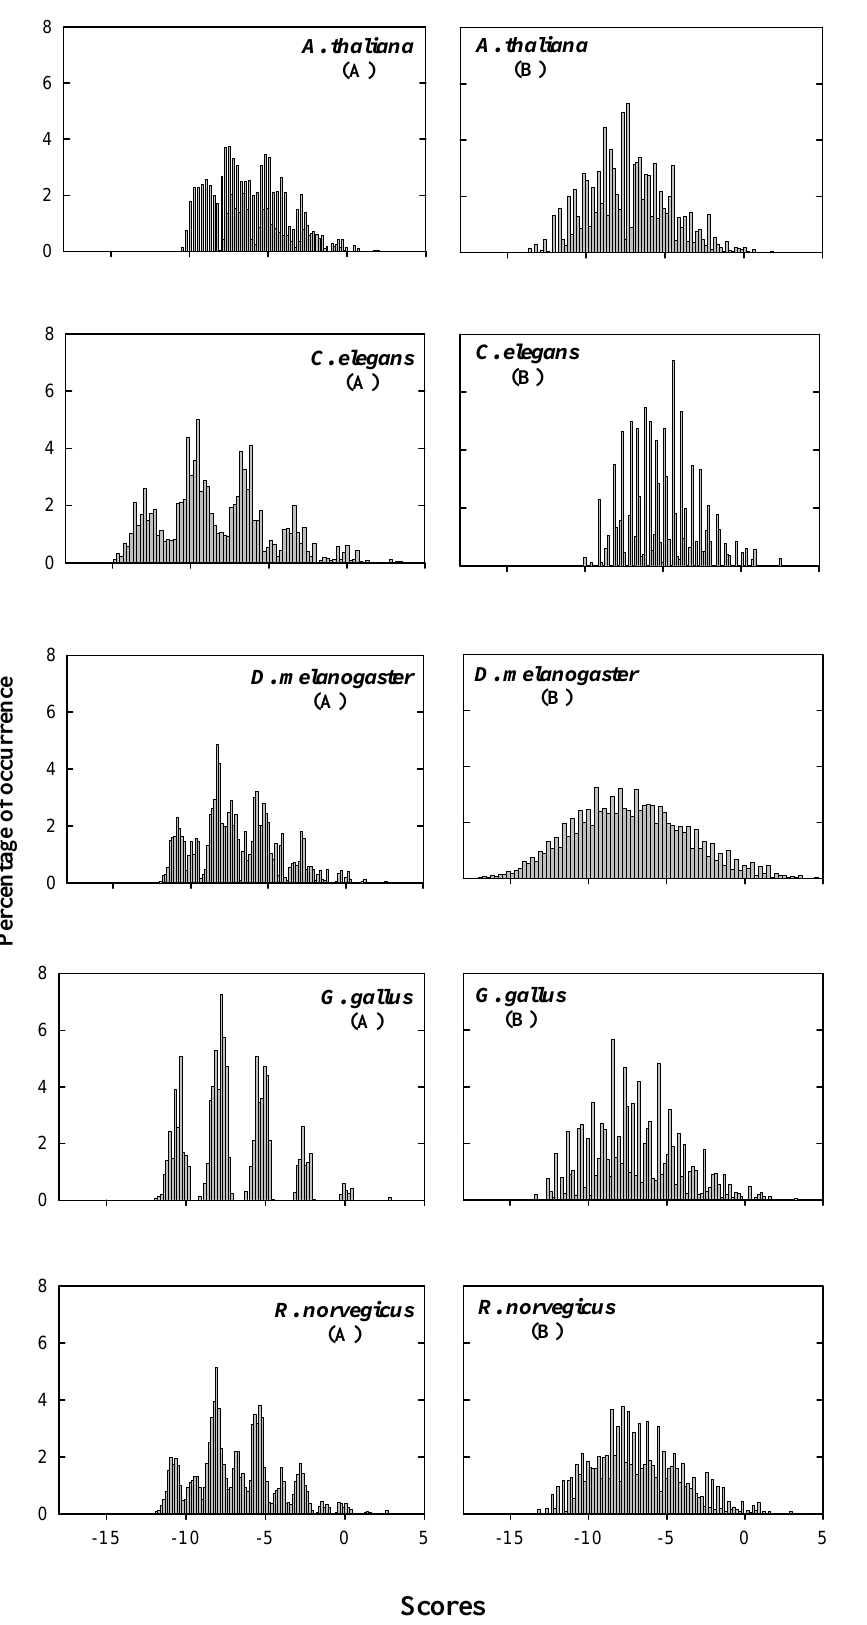
Fig 3. Histograms obtained by plotting the scores values (x-axis) against their percentage of occurrence (y-axis). These values were obtained by scoring the alignment of the (A; left